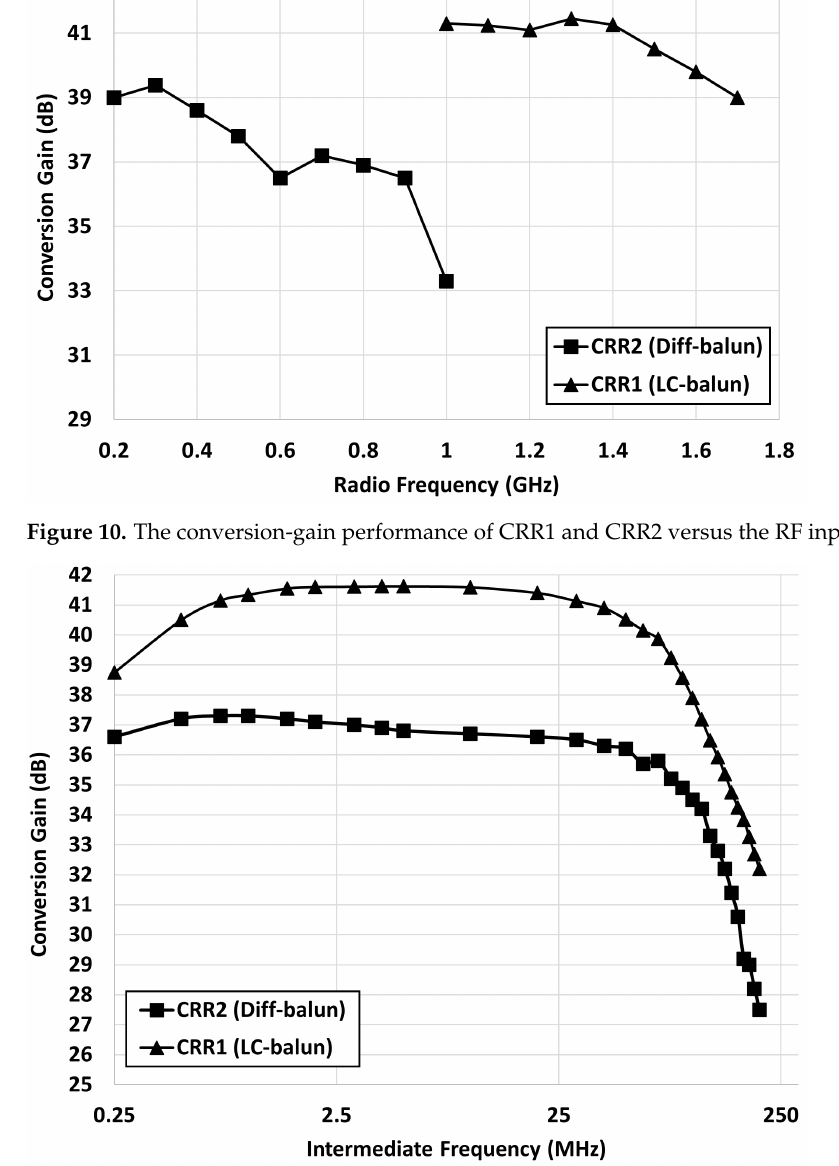
Figure 11. The conversion-gain performance of CRR1 and CRR2 versus the